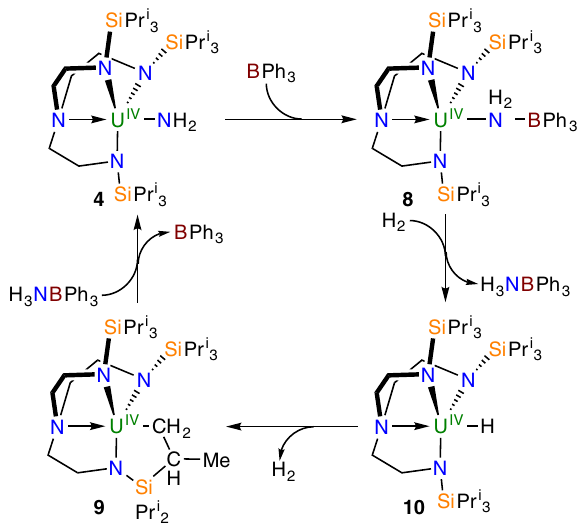
Fig. 6 Reactivity of 4. Treatment of 4 with BPh 3 results in formation of the adduct 8 . Addition of H 2 to 8 produces the hydride 10 with concomitant elimination of H 3 NBPh 3 . Complex 10 eliminates H 2 to produce the cyclometallate complex 9 , which in turn can react with H 3 NBPh 3 to reform 4